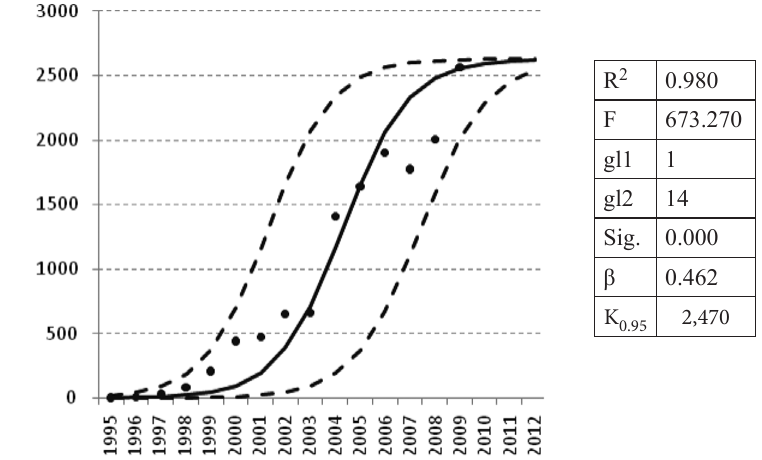
Fig. 9. Forecast of the ISO 9000 certificates in the Baltic States Source: Own preparation on the basis of ISO full reports of global statistics for ISO 9000 (ISO 1999-2010).